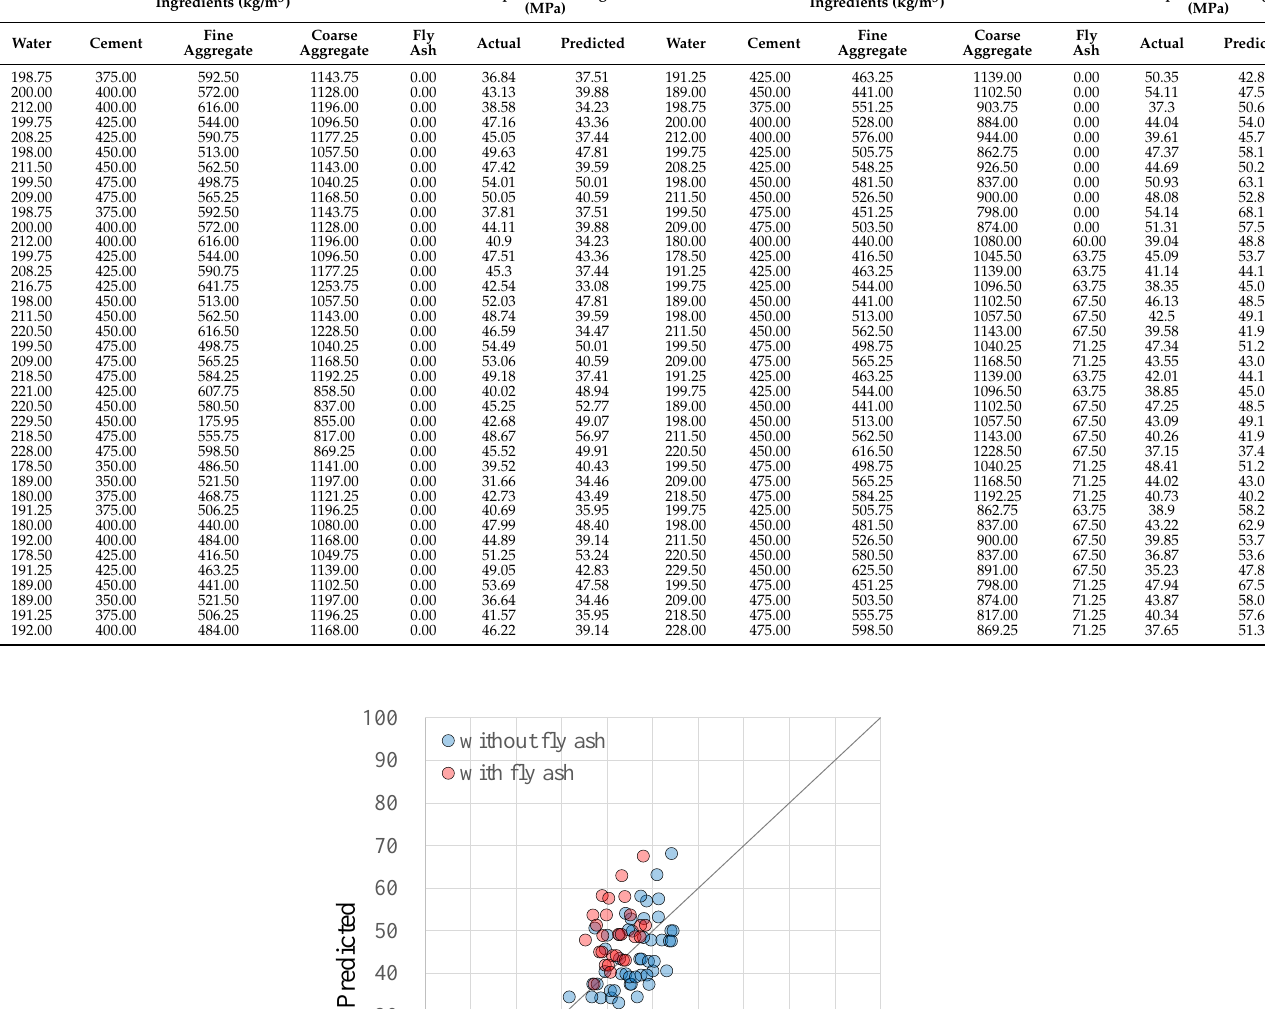
Table 5. The predicted and actual compressive strengths of the experimental concrete mixtures in [15]. Ingredients(kg/m 3 )